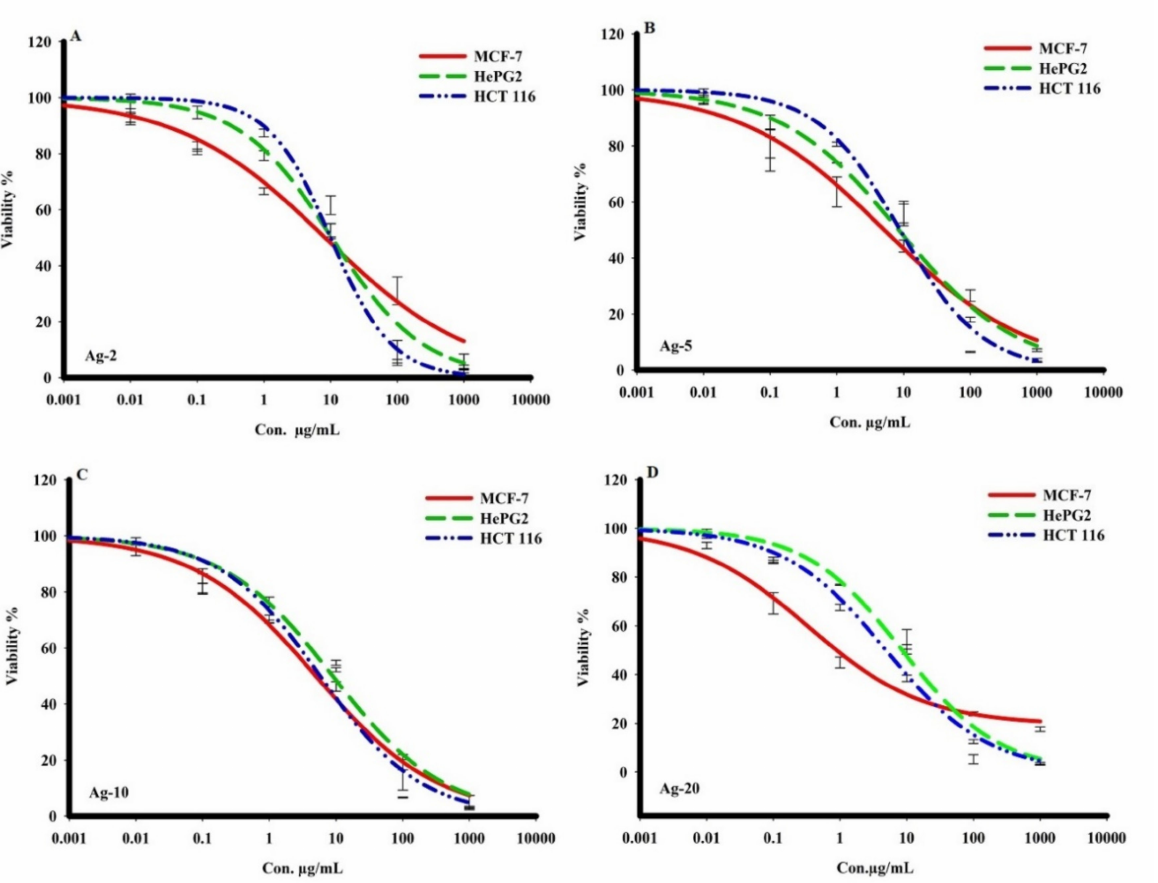
Figure 7. The cytotoxic activity of the prepared Ag-b-SiO 2 in MCF-7, HepG2, and HCT 116 human cancer cells. For 72 h, cells were exposed to various doses of isolated materials. SRB staining was used to assess cell